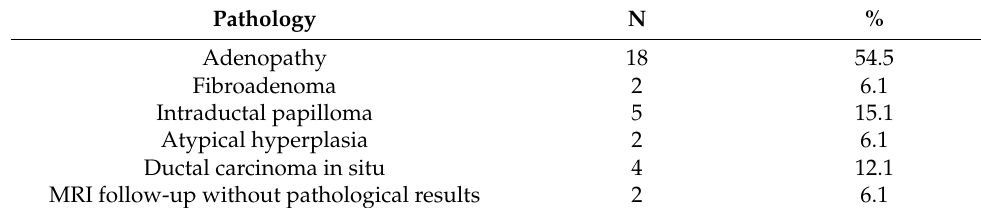
Table 2. Pathological results and MRI follow-up results of 33 included lesions.